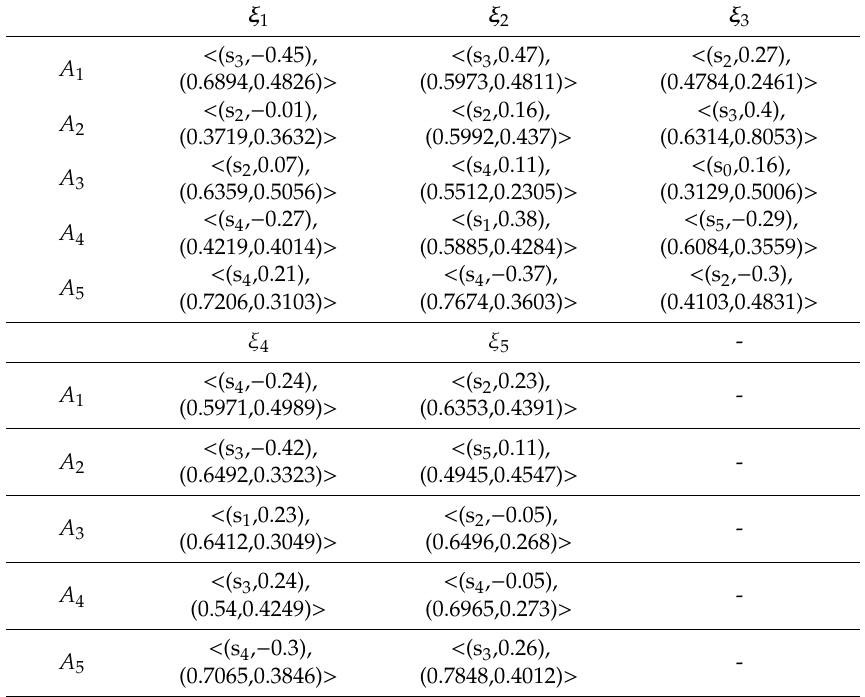
Table 6. P2TLN decision matrix.